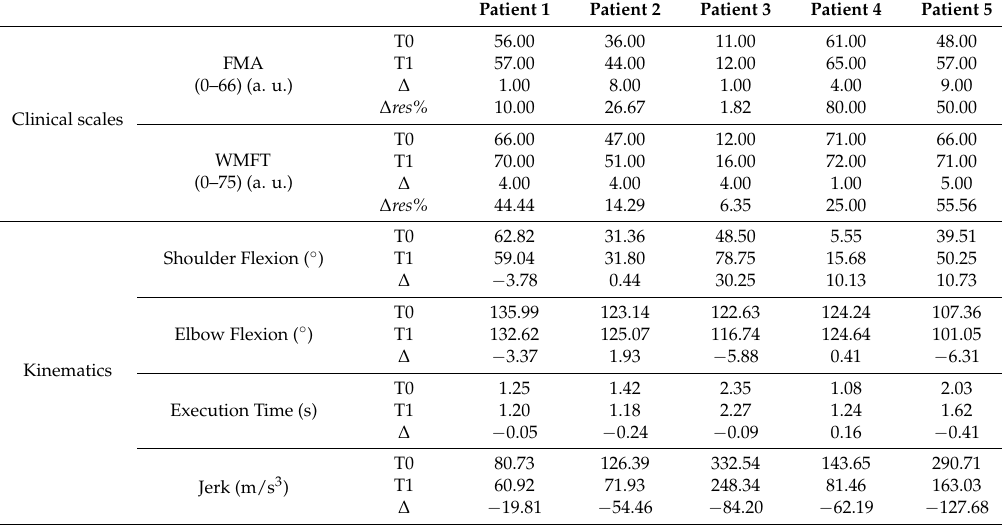
Table 1. Summary of the results: clinical scales and multi-domain approach. For each parameter